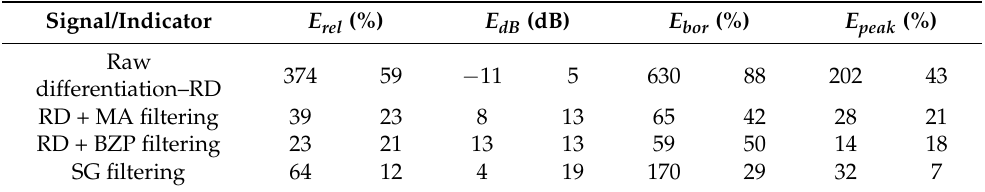
Table 6. Performance indicators for the second derivative obtained by raw numerical differentiation (RD) and low pass filtering or by polynomial filtering (SG) on the original 2 and 5 Hz noisy time signals.